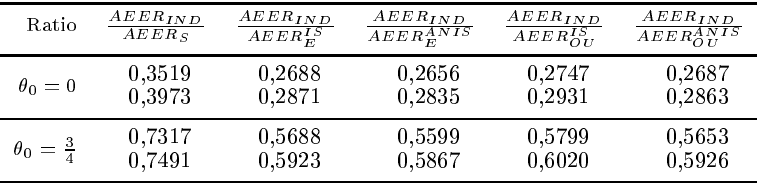
RatiosofAEERindandAEERinthecaseofdependentobservations(cid:8)